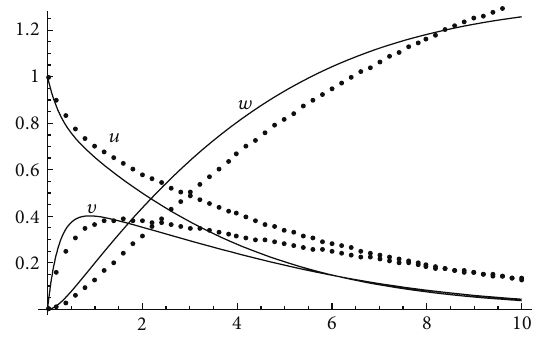
Figure 6: Profile of the normalized concentrations of the substrate 𝑢 , enzyme-substrate complex 𝑣 , and product 𝑤 for 𝑘 and 𝜀 = 0.6 , 𝛼 1 = 0.9 , 𝛼 2 = 0.85 , and 𝛼 3 = 0.95 (solid line); 𝛼 1 = = 1 , 𝜆 = 0.5 , = 𝛼 = 1 (dotted 𝛼 3 2 3